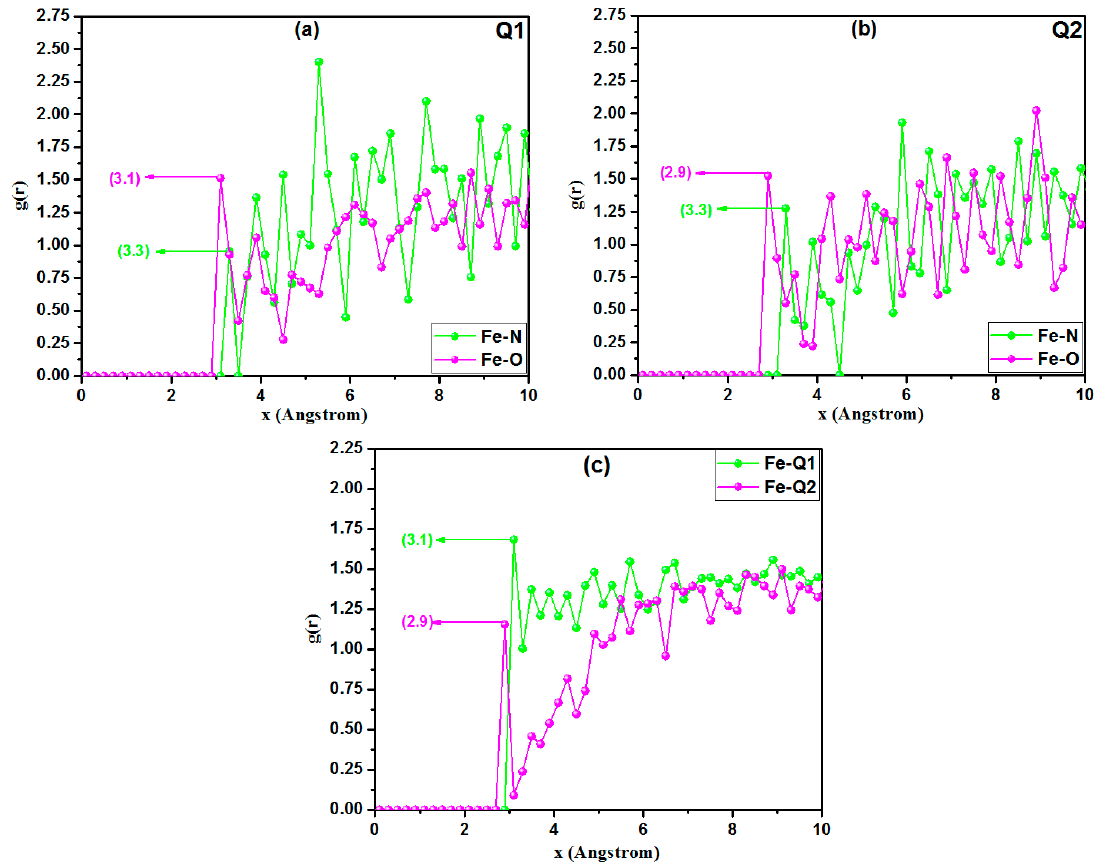
Figure 11. RDFs analysis of investigated Q1 and Q2 molecules on the Fe (110) surface in simulated solution, ( a ) Fe-heteroatoms of Q1, ( b ) Fe-heteroatoms of Q2, and ( c ) Fe-inhibitors.